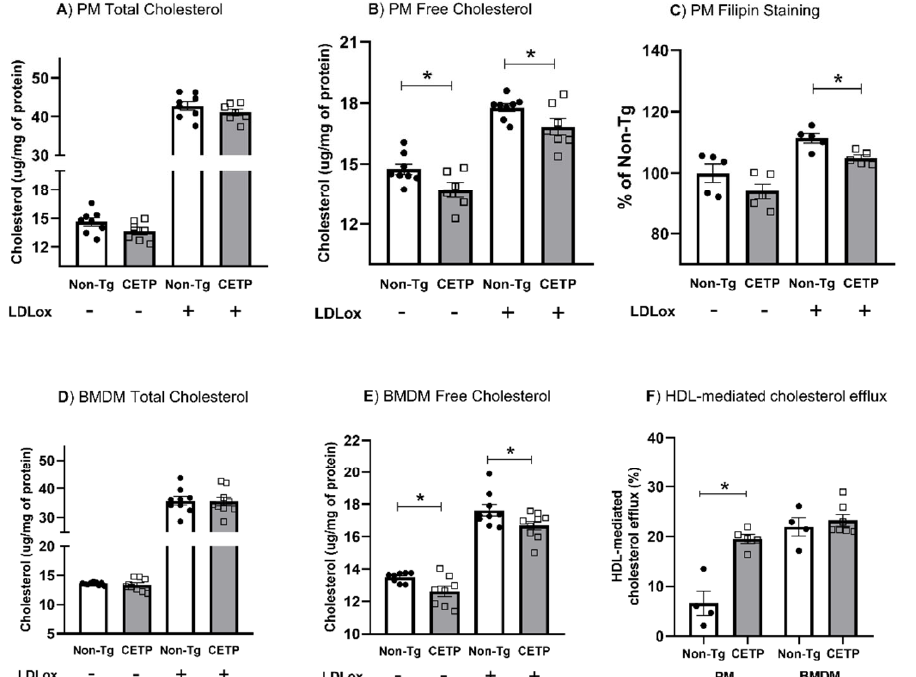
Figure 7. Macrophages expressing CETP present with reduced unesterified cholesterol content and increased cholesterol efflux. Cholesterol content before and after exposure to oxidized LDL (LDLox) were measured in thioglycolate-elicited peritoneal macrophage (PM, A , B ) and in bone marrow derived macrophage (BMDM, D , E ). Unesterified cholesterol was also measured by Filipin staining ( C ). HDL mediated cholesterol efflux was measured in resting PM and BMDM ( F ). See Material and Methods for details. * p < 0.05.